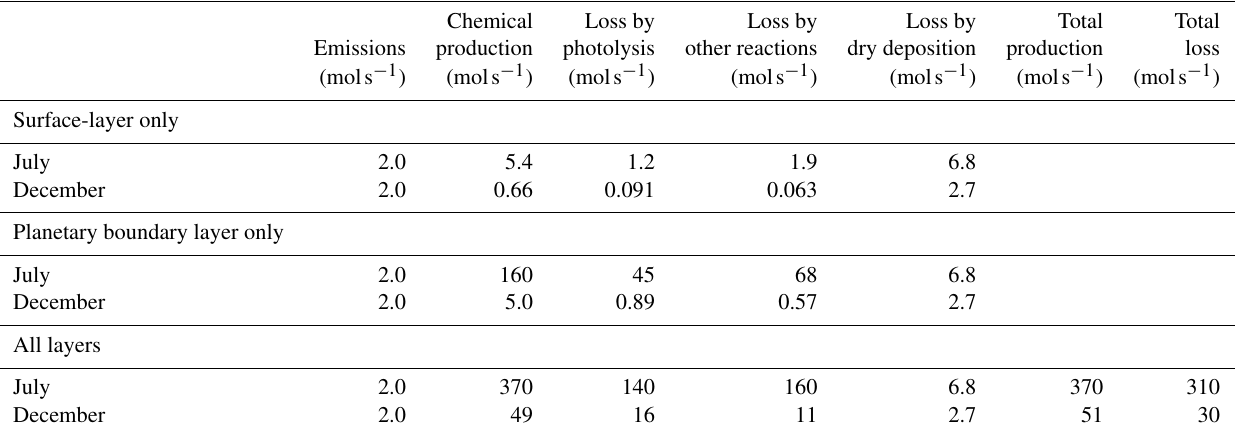
Table 2. Monthly average production and loss rates of formaldehyde by different mechanisms. Values are summed over the modeling domain. Chemical Loss by Loss by Loss by Total Total Emissions production photolysis other reactions dry deposition production loss (mols − 1 ) (mols − 1 ) (mols − 1 ) (mols − 1 ) (mols − 1 ) (mols − 1 ) (mols − 1 ) Surface-layer